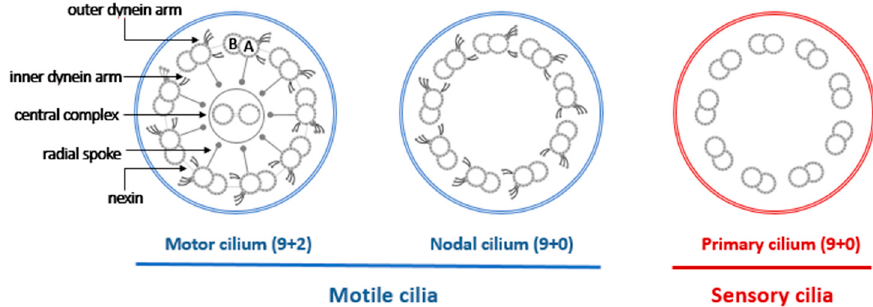
Figure 1. Diagram of basic cilia structure in 9+2 and 9+0 microtubule